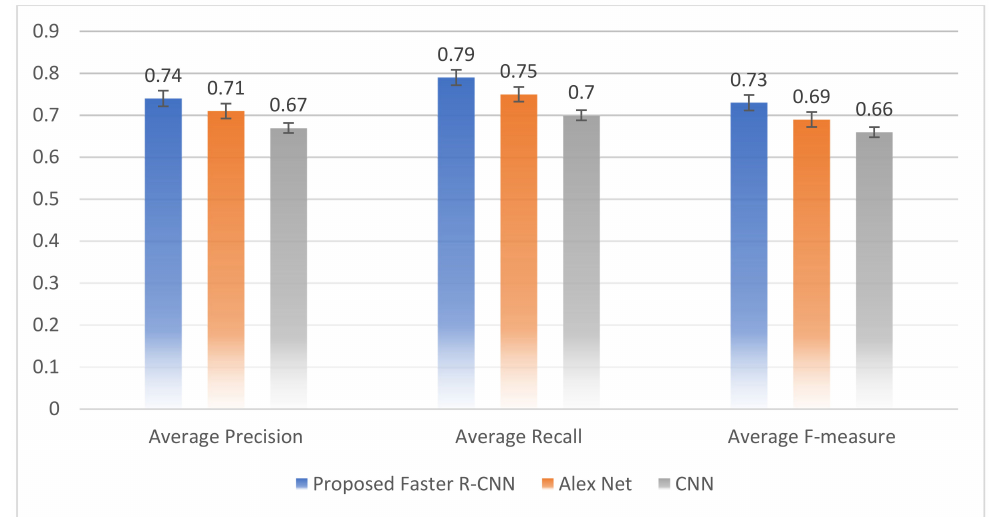
Figure 17. Precision-recall and F-measure performance of three